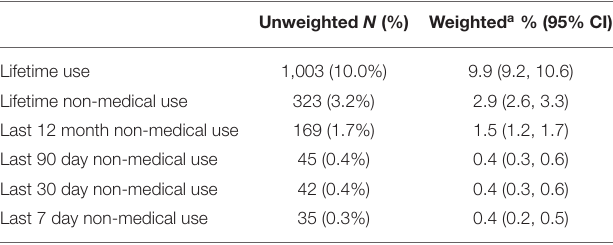
TABLE 4 | Respondents that reported use of gabapentinoids (from total survey respondents n = 10,062).